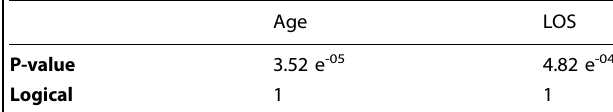
Table 3. Result of KS test for continuous